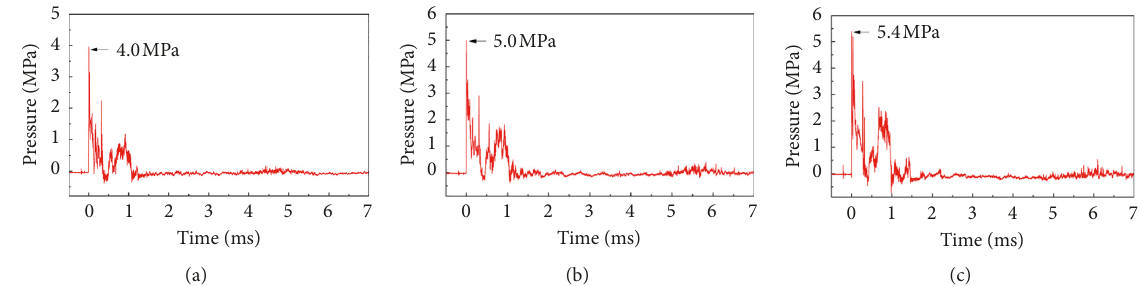
Figure 4: Waveforms of electric pulse wave: (a) 5 g energetic bomb; (b) 10g energetic bomb; (c) 15g energetic